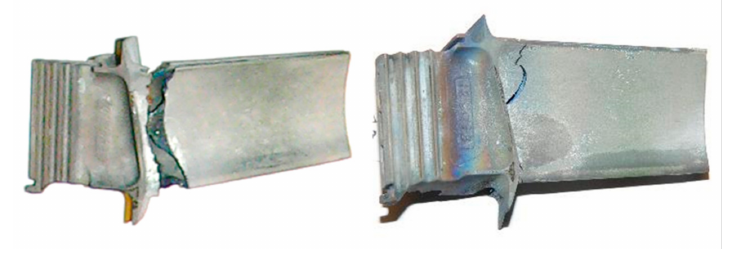
Figure 15. Photograph of the turbine blades after fatigue testing at 950 ◦ C.